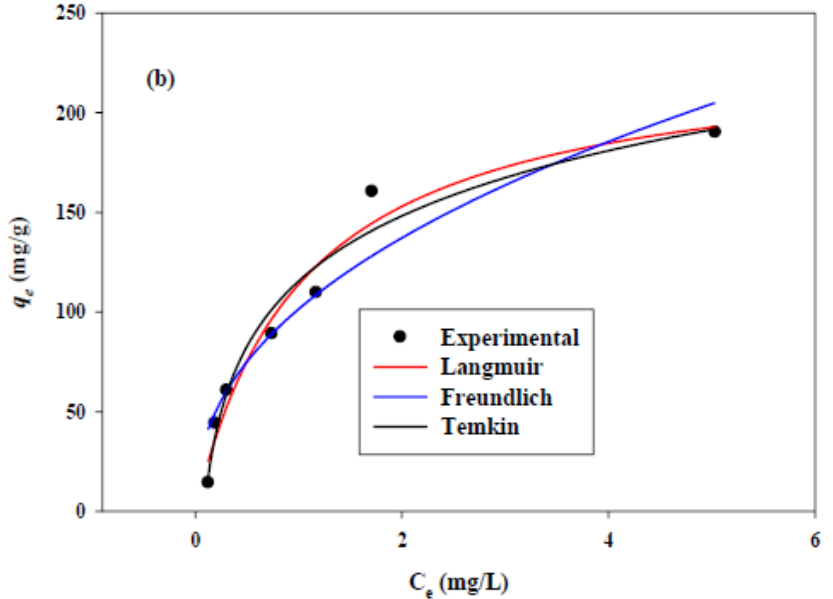
Figure 8. ( a ) Contact-time effect on MB adsorption at various concentrations; ( b ) MB adsorption Figure 8. (a) Contact-time effect on MB adsorption at various concentrations; (b) MB adsorption isotherms (dose = 0.09 g, solution pH = 8.7, temperature = 25 °C, stirring speed = 90 rpm, and volume isotherms (dose = 0.09 g, solution pH = 8.7, temperature = 25 ◦ C, stirring speed = 90 rpm, and volume of solution = 100 mL). of solution = 100 mL).